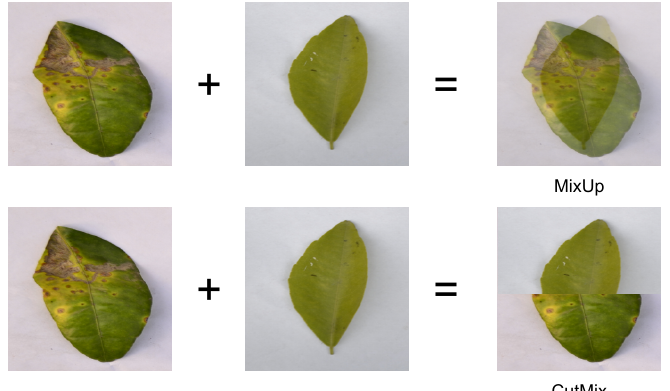
Figure 2. Mix-link pairs are generated by combining a single image with a mixture of MixUp [25] or CutMix [26] augmented images. λ being the ratio of the first image in the augmented image, the distance for the mix-link pairs is calculated by λα + ( 1 − λ ) α .